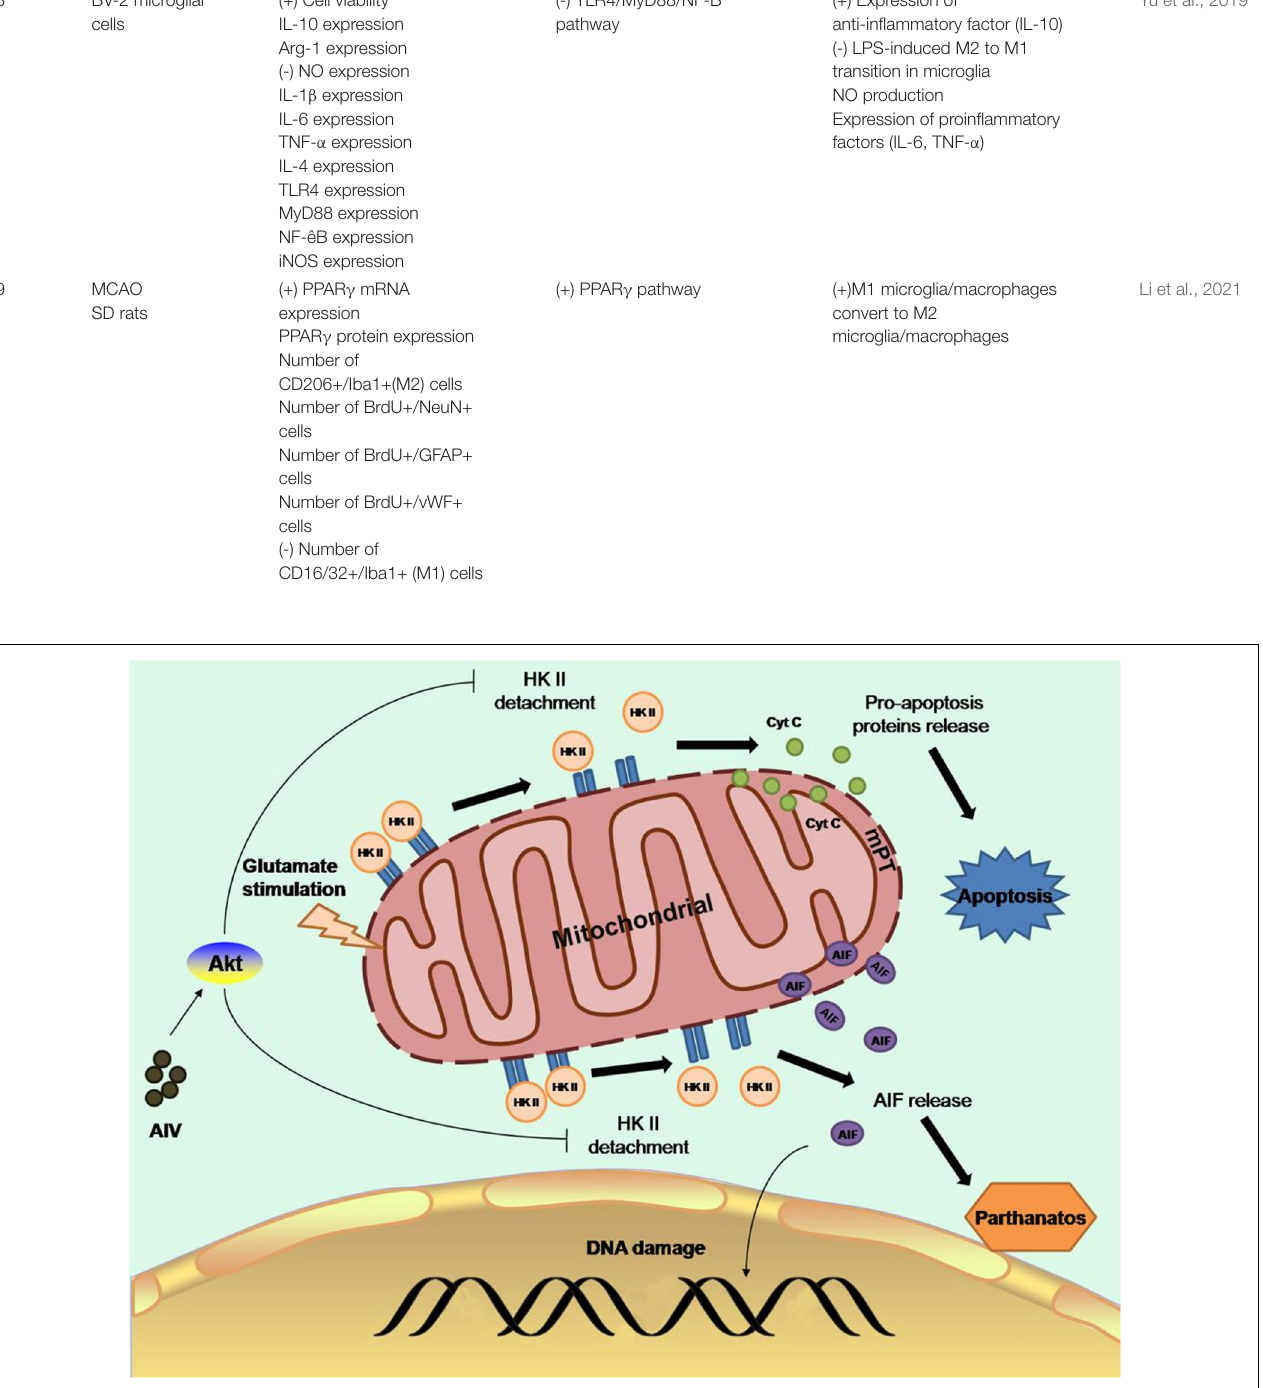
Frontiers in Neuroscience |